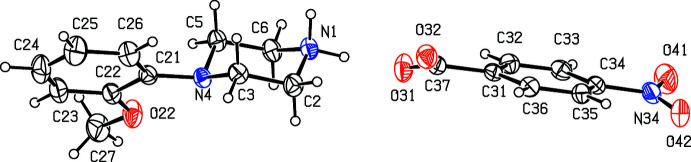
The independent components of compound (X) showing the atom-labelling scheme. Displacement ellipsoids are drawn at the 30% probability level.